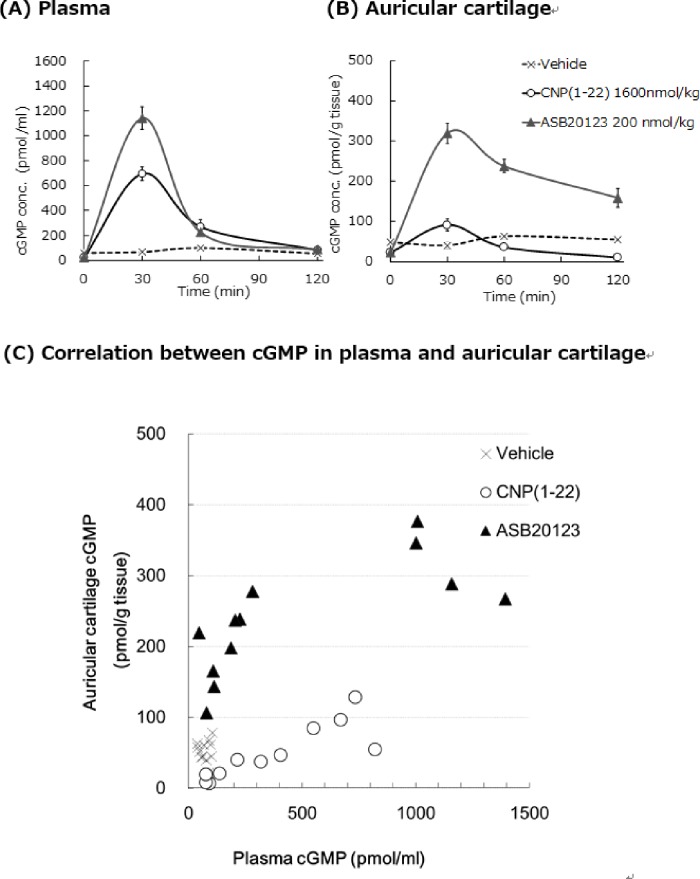
cGMP concentration-time curves in plasma and auricular cartilage after a single sc dose of CNP(1–22) or ASB20123 in mice.Plasma (A) or auricular cartilage (B) cGMP concentration-time curves after a single sc dose of CNP(1–22) at 1600 nmol/kg or ASB20123 at 200 nmol/kg in mice. Correlation between cGMP concentrations in plasma and in auricular cartilage at each sampling point (C). Each value represents the mean ± SD of 4 mice (A, B) or individual value (C).